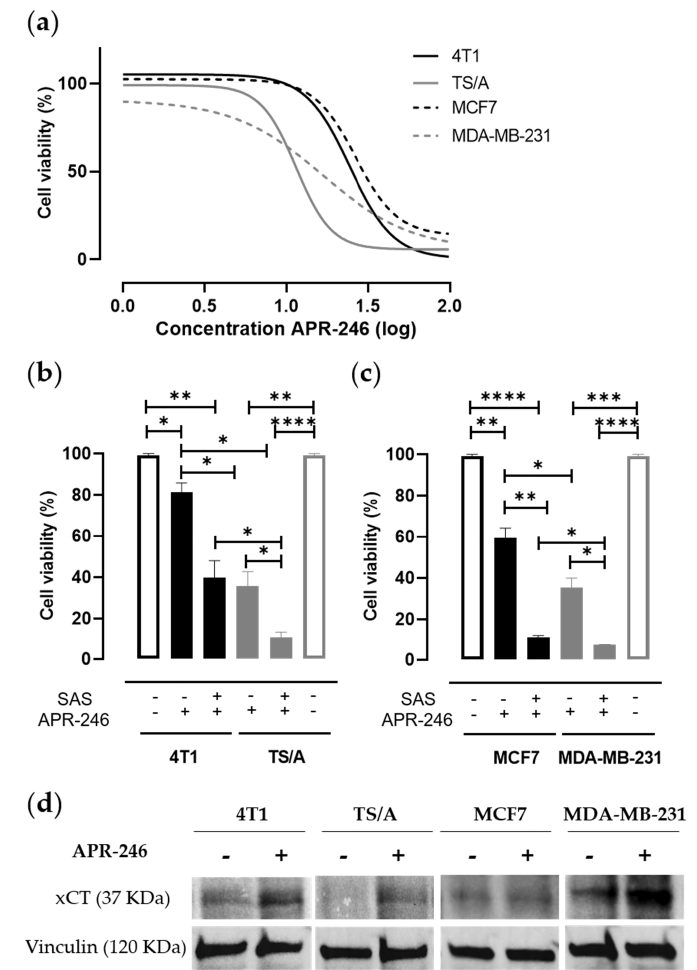
Figure 1. Effect of APR-246 alone or in combination with SAS on mammary tumor cell viability. ( a ) MTT proliferation assay performed on cells cultured for 24 h in the presence of scalar doses of APR- 246. The percentage of cell viability measured in treated cells as compared to that measured in untreated cells grown in the presence of medium (no drugs) was calculated. The graph shows log(inhibitor) vs. response-variable slope (four parameters) nonlinear regression of data from three independent experiments, calculated with GraphPad9 software. ( b , c ) Histograms represent the percentage (mean value ± mean of the standard error, SEM) of the cell viability following 24 h incubation with 25 µM or 12.5 µM of APR-246 for mut-p53 or p53 wild-type cells, respectively, alone or in combination with 100 µM of SAS. Results are reported in comparison to cells grown in the presence of medium, considered as control (100%). * p < 0.05; ** p ≤ 0.002; ** p = 0.0002; **** p < 0.0001; Student t test. ( d ) Immunoblot revealing xCT expression in cancer cell line panel treated or not with APR-246 (25 µM for 4T1 and MCF7; 12.5 µM for TS/A and MDA-MB-231) for 16 h. Vinculin was used as loading control protein.